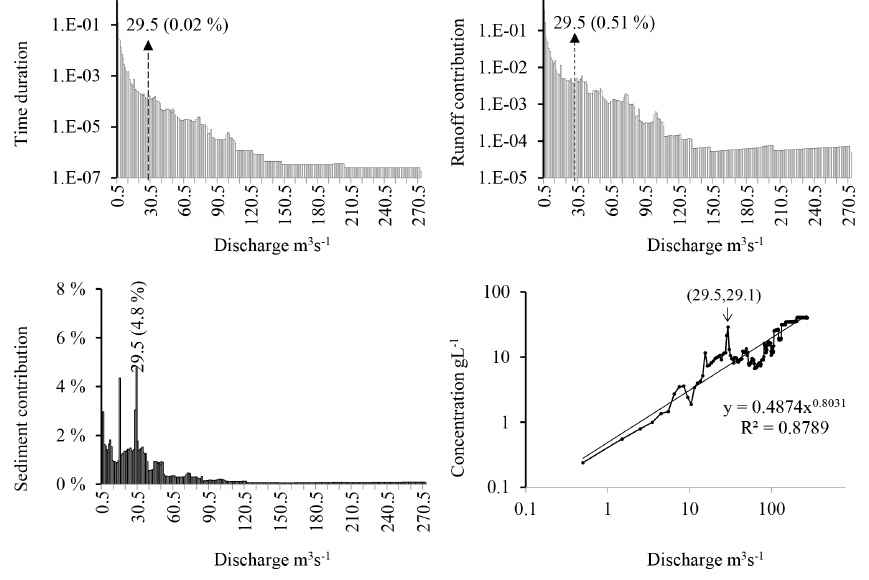
Figure 4. Duration, water and sediment supplies, as well as the sediment rating curve with a subdivision into classes of equal length (1m 3 s − 1